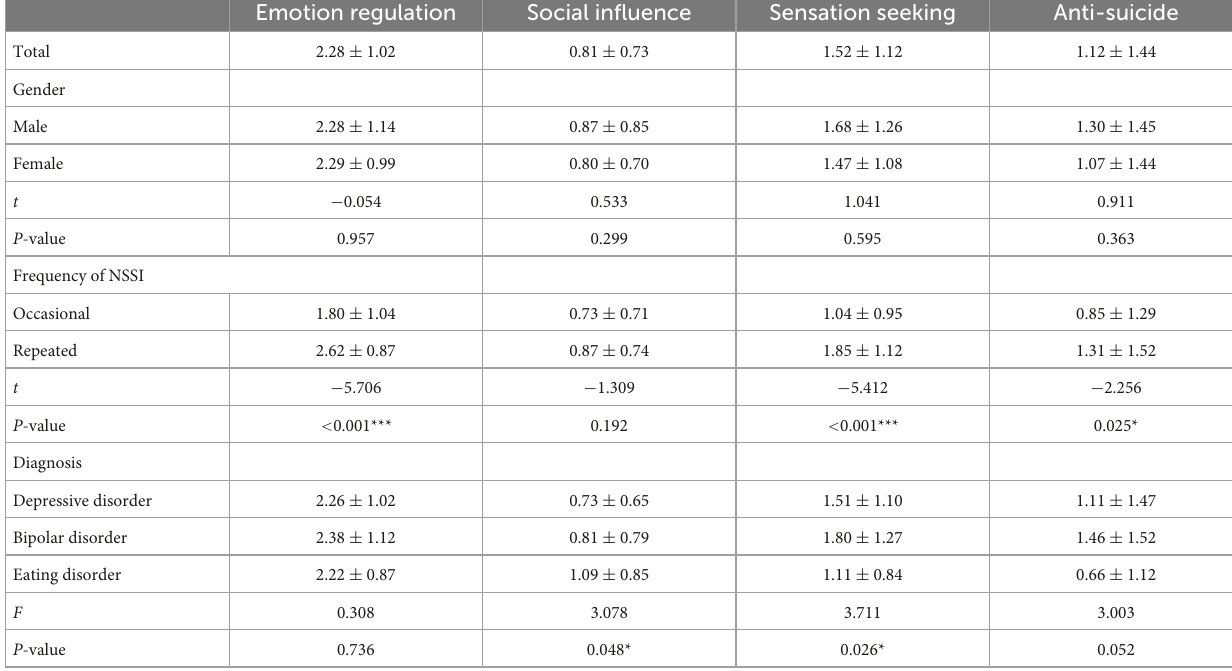
TABLE 2 The average function scores of participants with NSSI [mean ± SD]. Emotion regulation Social influence Sensation seeking